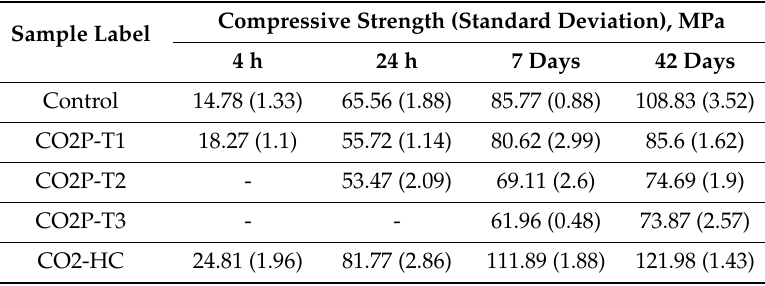
Table 4. Compressive strengths of the paste samples.